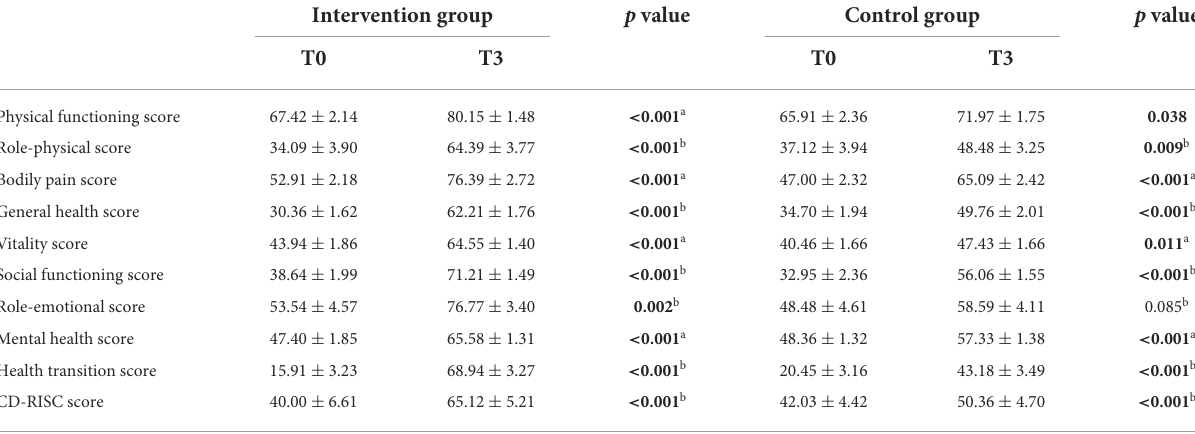
TABLE 3 SF-36 and CD-RISC scores of the intervention and control groups at baseline (T0) and three-month follow-up